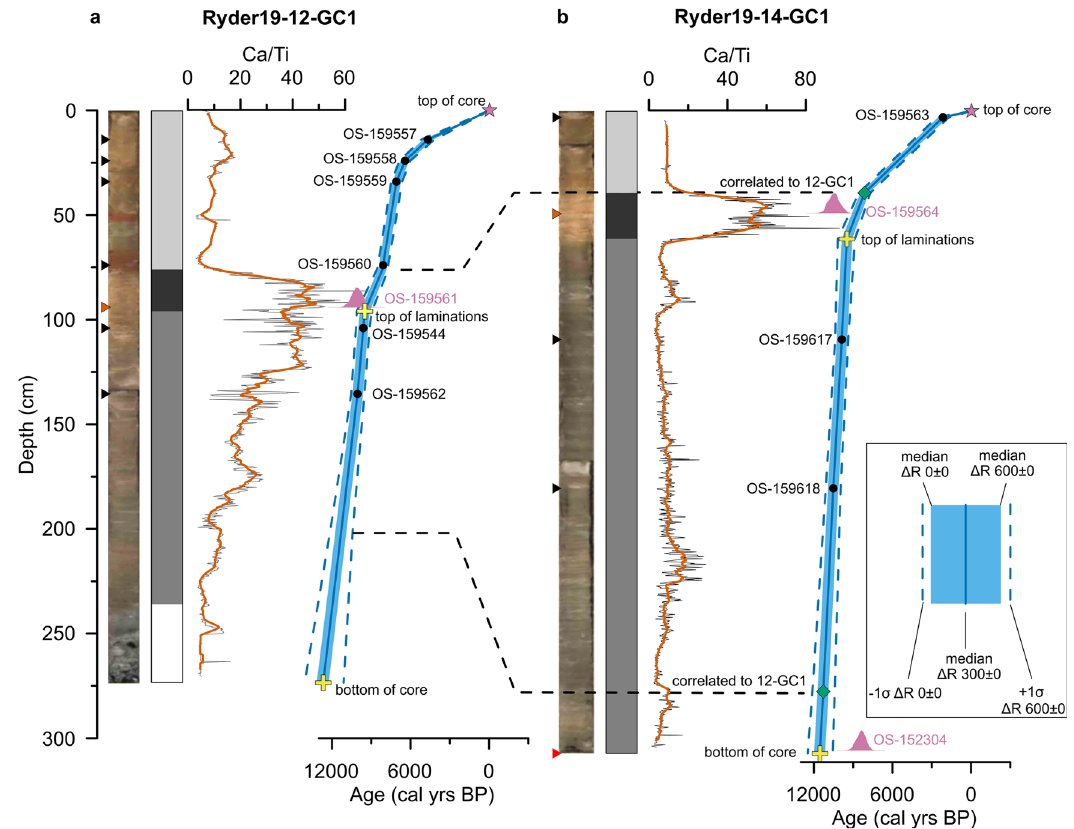
Fig. 6 Age model and correlation of 12-GC and 14-GC. Core photos, schematic of major lithological units (as in Fig. 5), XRF Ca/Ti (black, 20-pt average in red-brown), and age-depth relationship of ( a ) 12-GC and ( b ) 14-GC, including the correlation between both cores (horizontal black dashed lines). The depth of individual radiocarbon ages is marked with triangles on the core photos and black dots on the age-depth relationship graph. Boundaries used for age modelling (see text) are marked by yellow crosses, age-depth tie points with green diamonds, and the top of each core is indicated with a pink star. The likelihood distribution (pink) is shown for outlier radiocarbon ages. Both age models include the mean (blue line) based on a Δ R of 300 ± 0 and the uncertainty envelope (light blue) based on a Δ R uncertainty of 300 ( Δ R = 0 ± 0 and Δ R = 600 ± 0). The dashed blue lines indicated the 1 σ uncertainty of the smallest/largest Δ R,